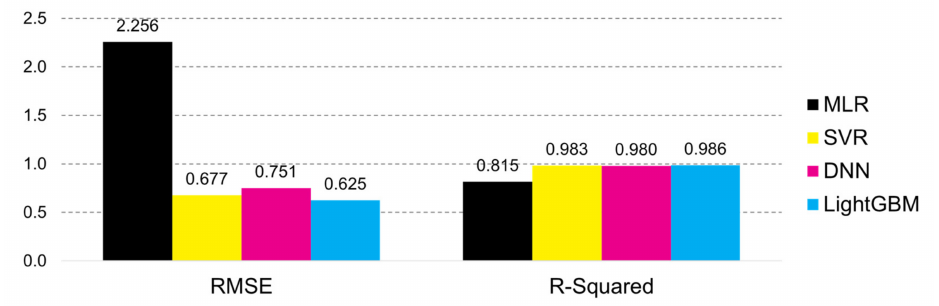
Figure 8. Performance comparison of four famous regression models in the medical field. Multiple linear regression (MLR); support vector regression (SVR); deep neural network (DNN); and Light gradient boosting machine